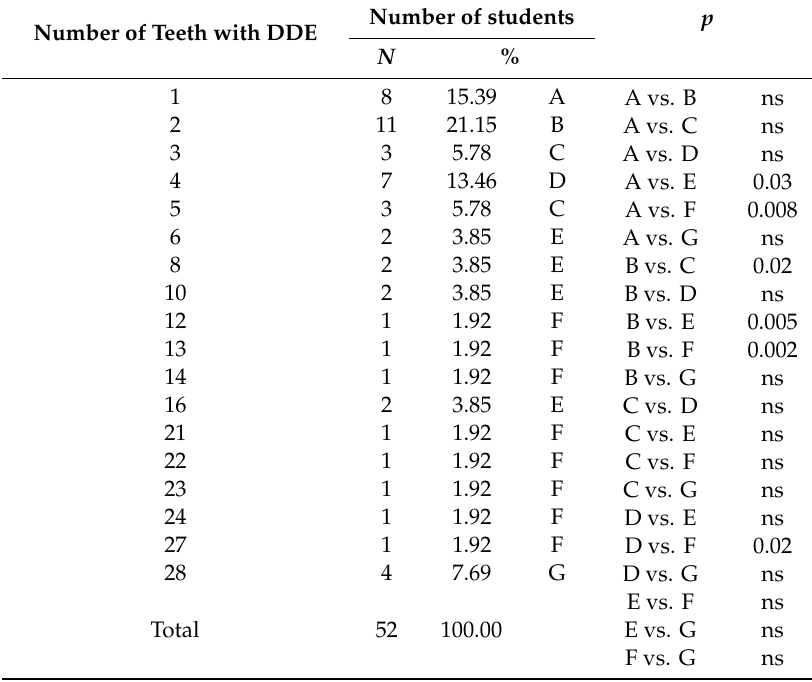
Table 6. Number of teeth with DDE in special-care students. Number of Teeth with